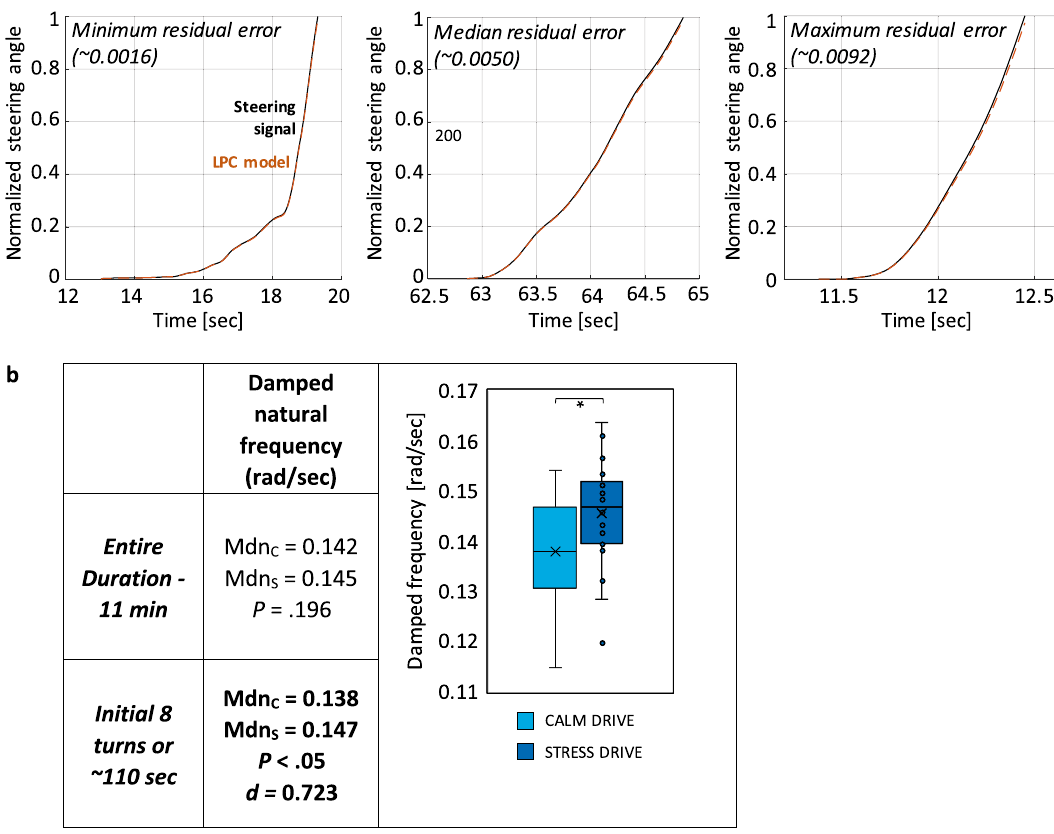
Figure 3. Results for cohort analyses. ( a ) LPC model fit with minimum, median, maximum variance of the residual errors across participants. Overall LPC models showing good quality of fit in all three examples. ( b ) Shows median values and boxplots of damping frequencies, with “c” = calm drive, “s” = stress drive, and ‘d” = Cohen’s d. P values need to fall below 0.0125 to be significant due to Bonferroni correction for multi-